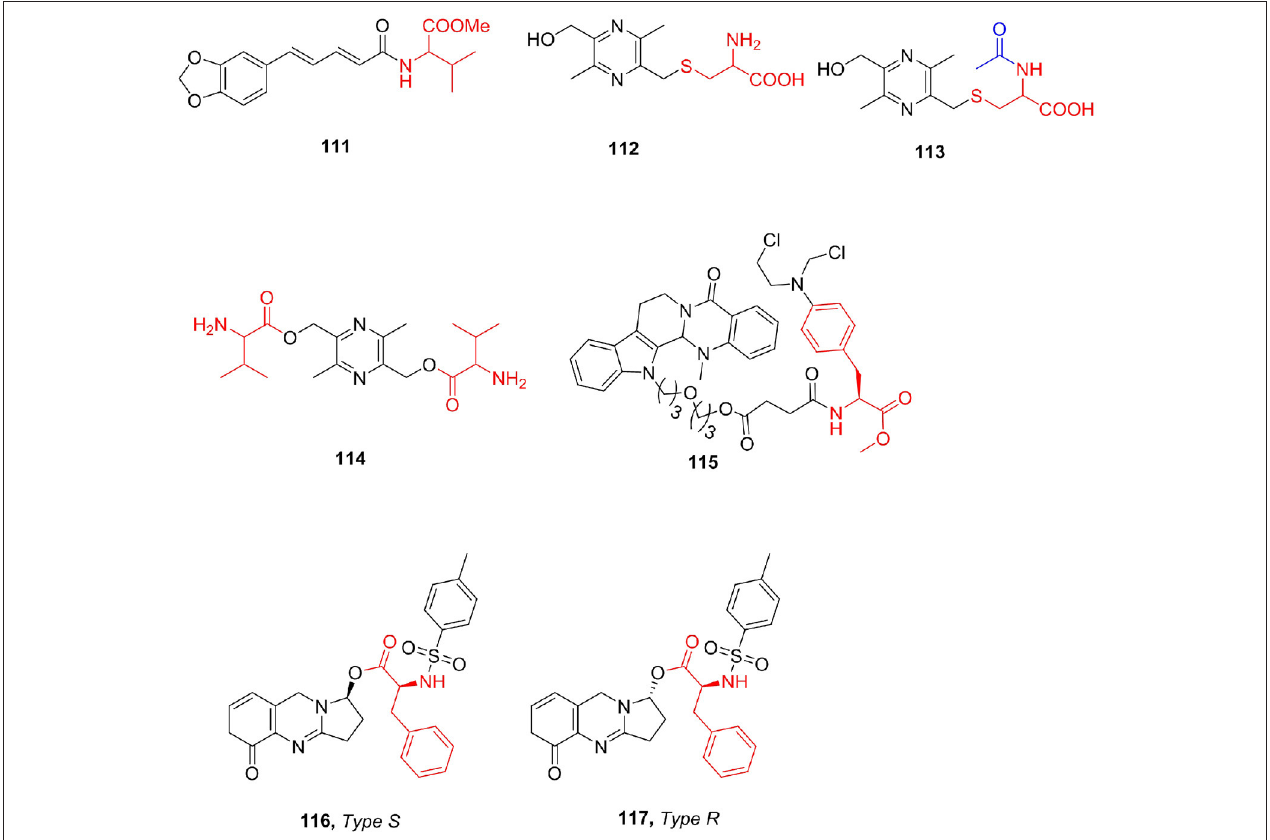
FIGURE 14 | Alkaloids amino acid